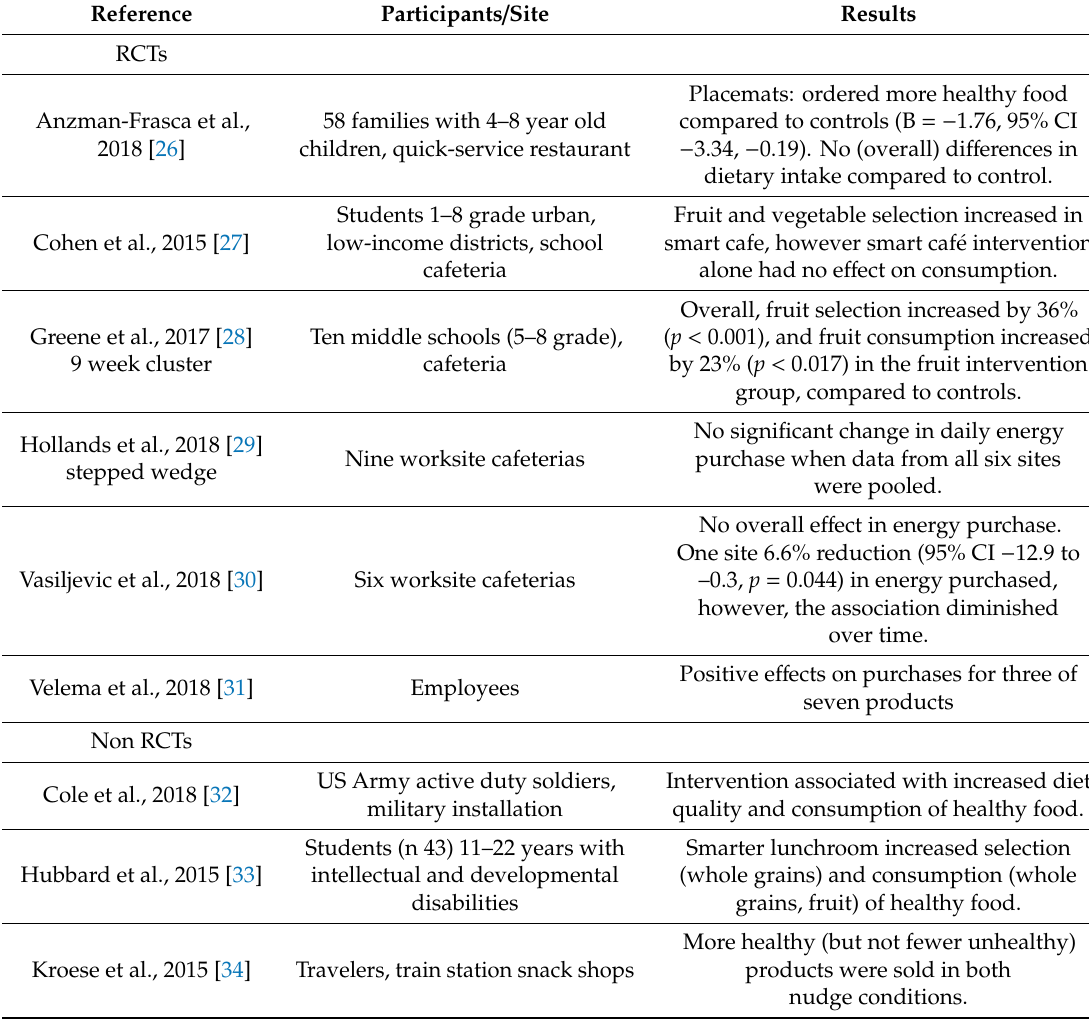
Table 3. Characteristics of included